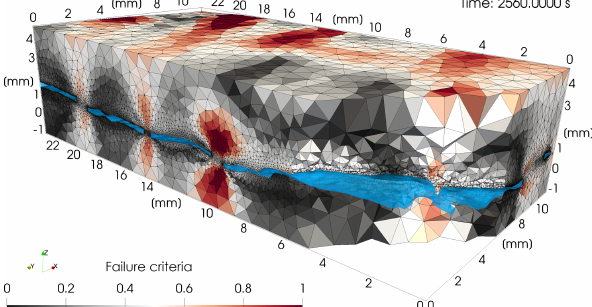
Figure 8. Normalized failure criterion: τ oct /(a + bσ m, 2 ) based on true tri-axial testing in the matrix-fracture system after applying 17MPa normal stress at the top